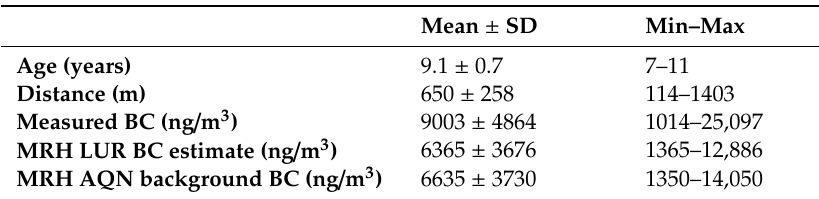
Table 1. Study characteristics. 43 children who walked to school were included in the analysis. 24 children were female, 19 were male.